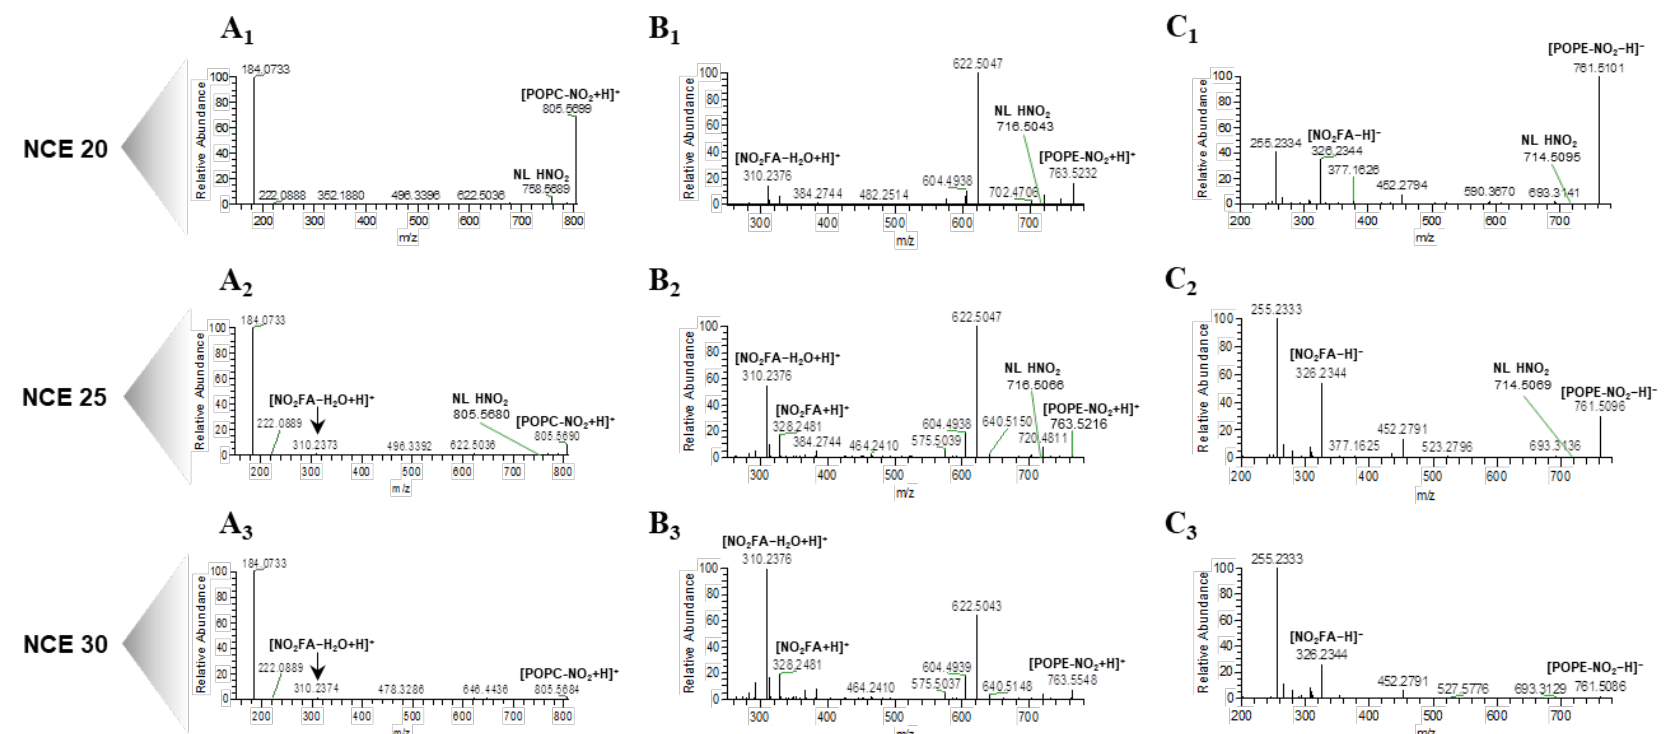
Figure 1. Electrospray (ESI)-high resolution (HR)-HCD-MS / MS spectra of the ions ( A ) (NO 2 -POPC + H) + at m / z 805.6, ( B ) (NO 2 -POPE + H) + at m / z 763.5 and ( C ) (NO 2 -POPE − H) − ions at, m / z 761.5, respectively, acquired in a Q-Exactive Orbitrap mass spectrometer at a concentration of 2 µ g mL − 1 , with a low normalized collision energy (NCE) (20) A1 , B1 , C1 ; medium NCE (25) A2 , B2 , C2 and high NCE (30) A3 , B3 , C3 , respectively.